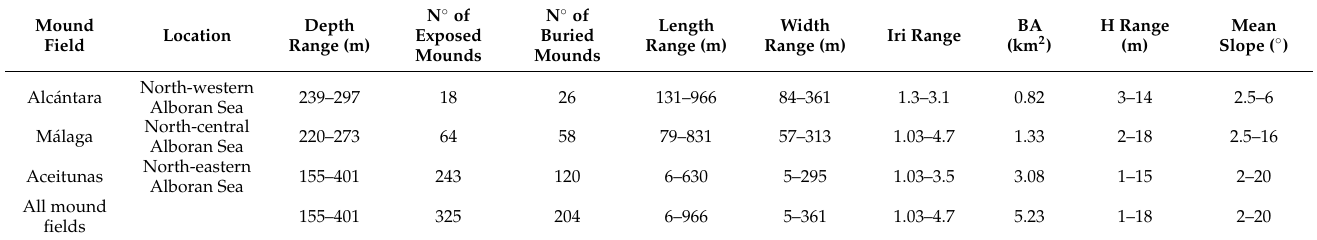
Table 2. Location, number (N ◦ ) and morphological features of the mounds and mound fields detected in the northern Alboran Sea (Iri: Irregularity index, BA: Basal Area, H: